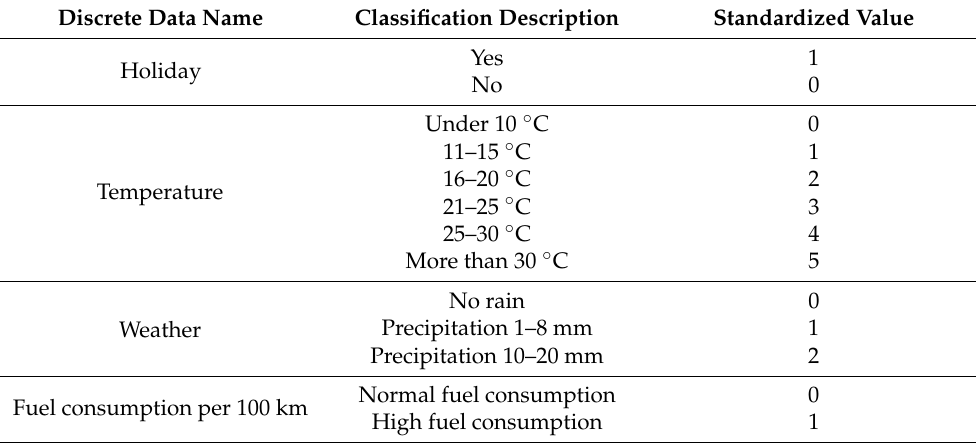
Table 3. Standardized treatment for discrete variables.